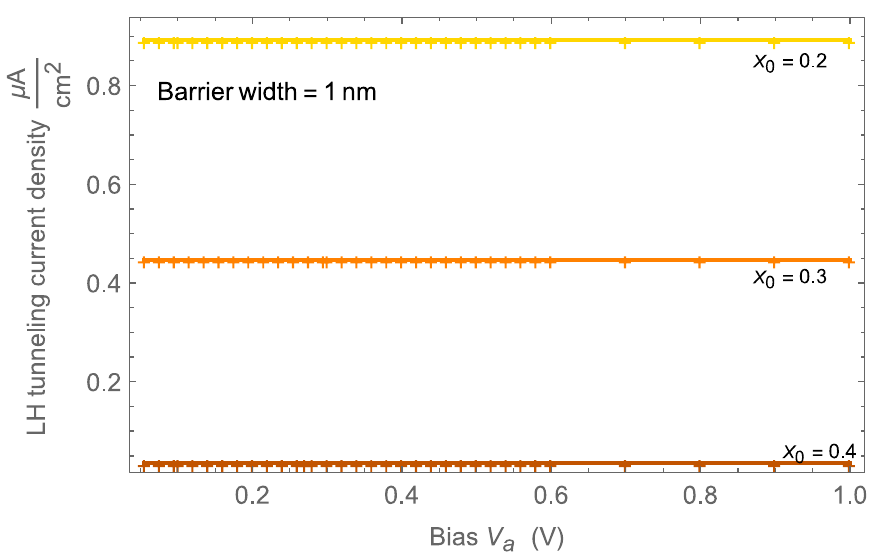
Figure 16. Current density-voltage characteristics of the LH tunneling at width barrier 1 nm.